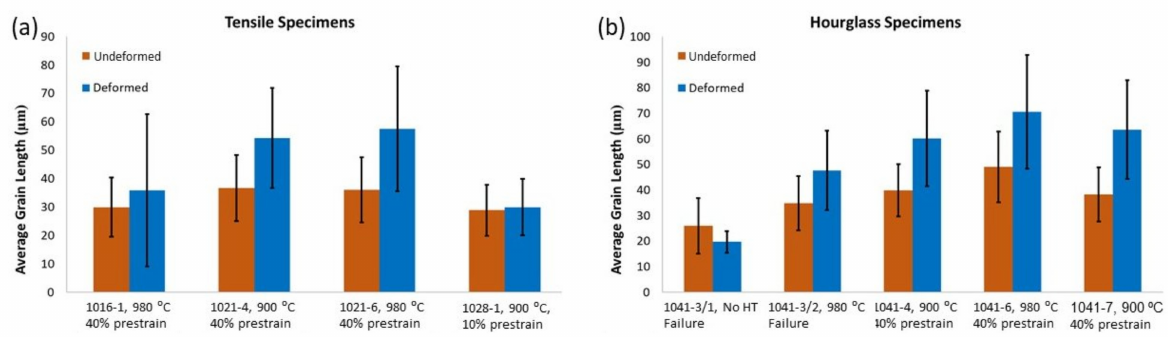
Figure 7. Grain length statistics along the load direction for varying degrees of prestrain and different heat treatments. ( a ) shows the tensile specimen grain length for undeformed and deformed grains; ( b ) shows the hourglass specimen grain elongation for undeformed and deformed